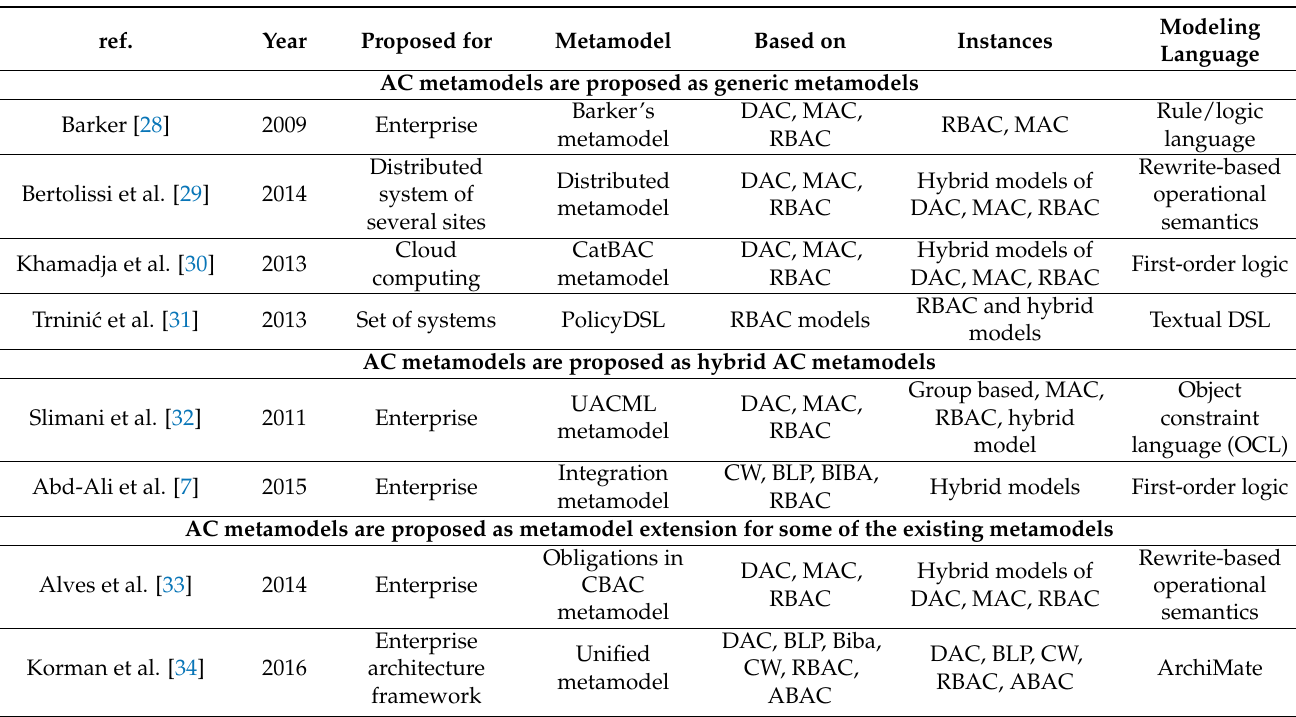
Table 1. Access control metamodels: the state-of-the-art [5,9].